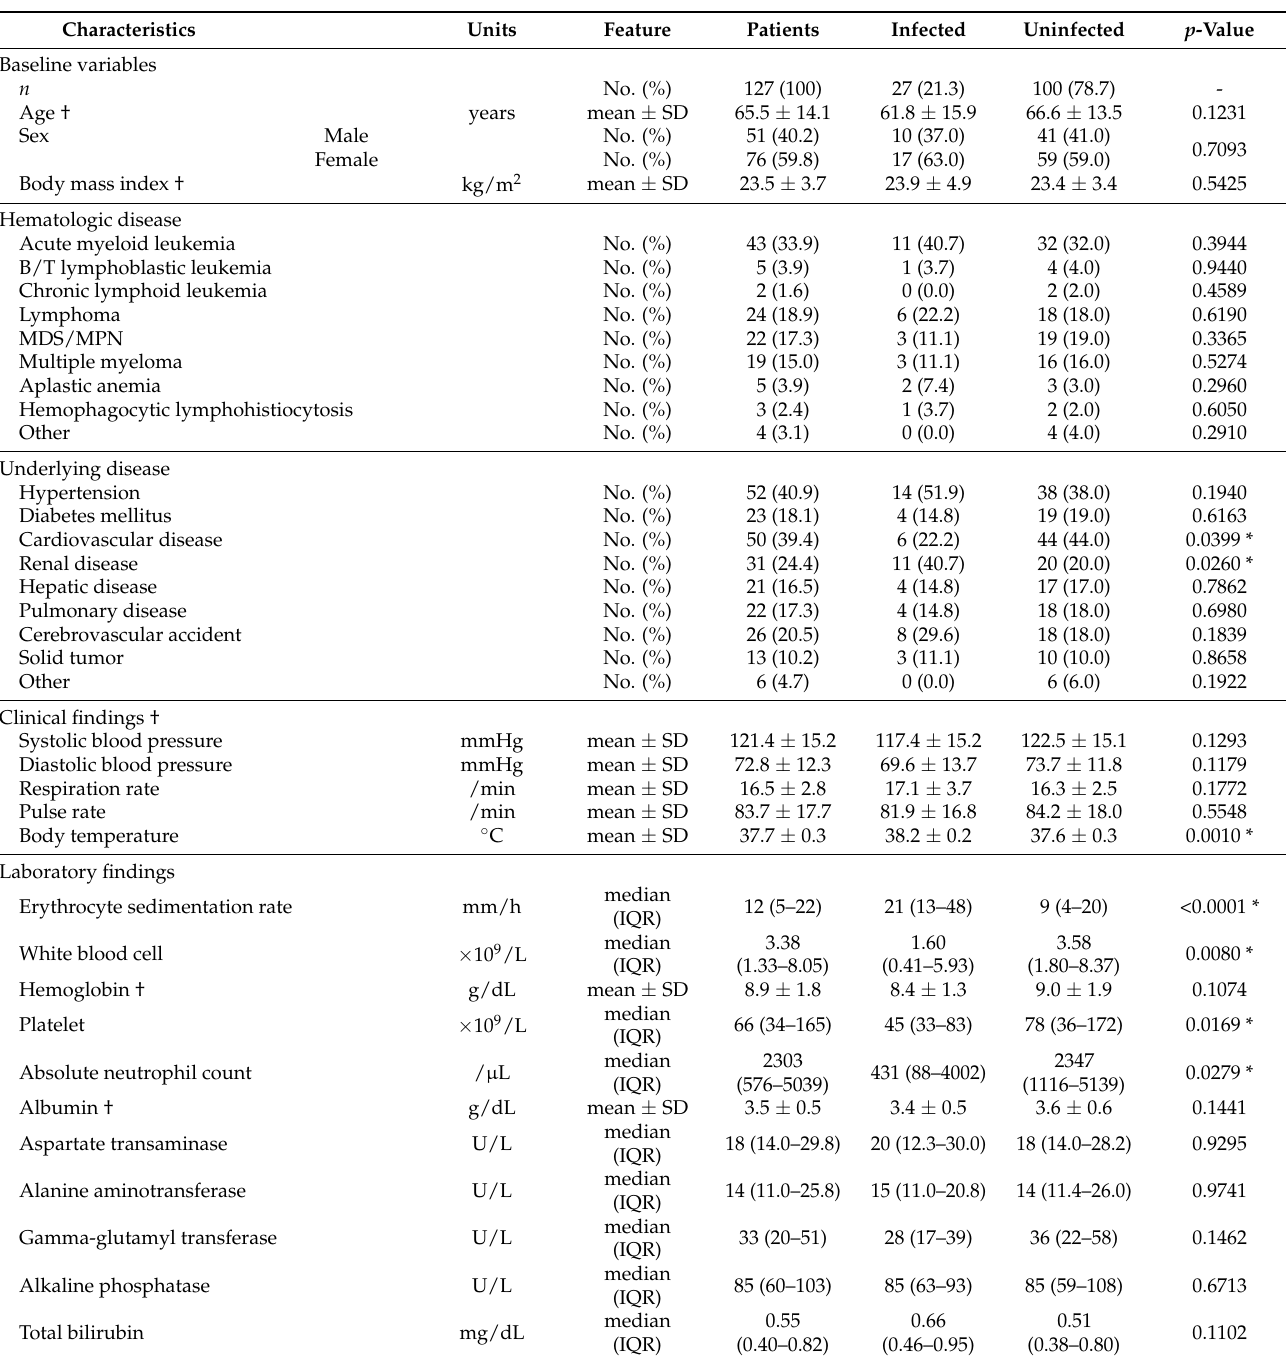
Table 1. Baseline characteristics of patients ( n =